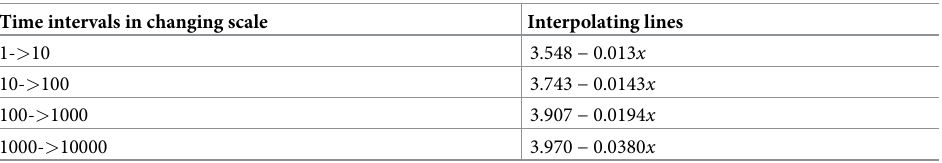
On the left column, time intervals in the number of infected individual. On the right column, the fitting curve values for countries passing through the progression that goes from 1 to 10, to 100, to 1000, to 10000, to 100000 and so on. The data fit is performed on a scale (x, Log(y)). Interestingly, the slope of the interpolating curve increases from one interval to